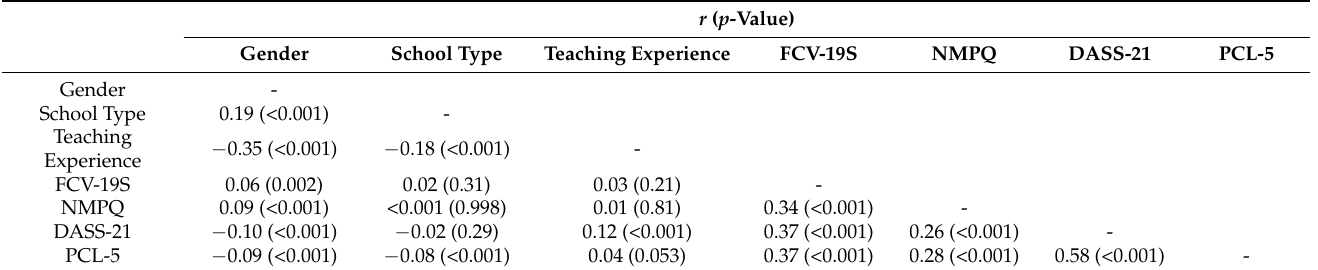
Table 2. Correlation matrix for studied variables.